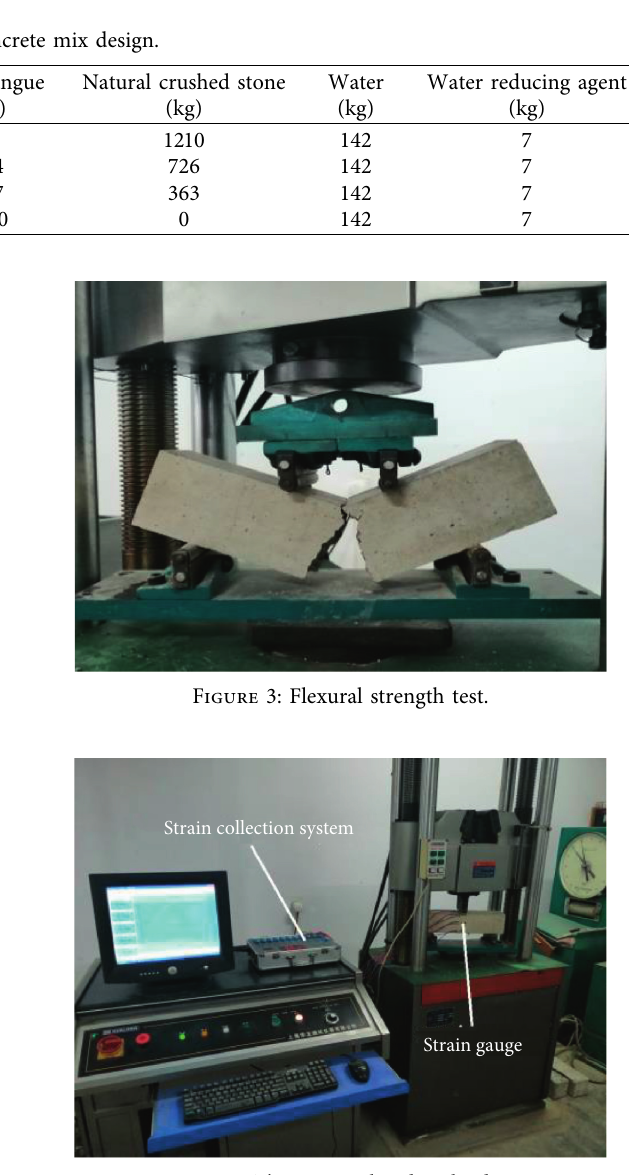
Figure 4: Three-point bending